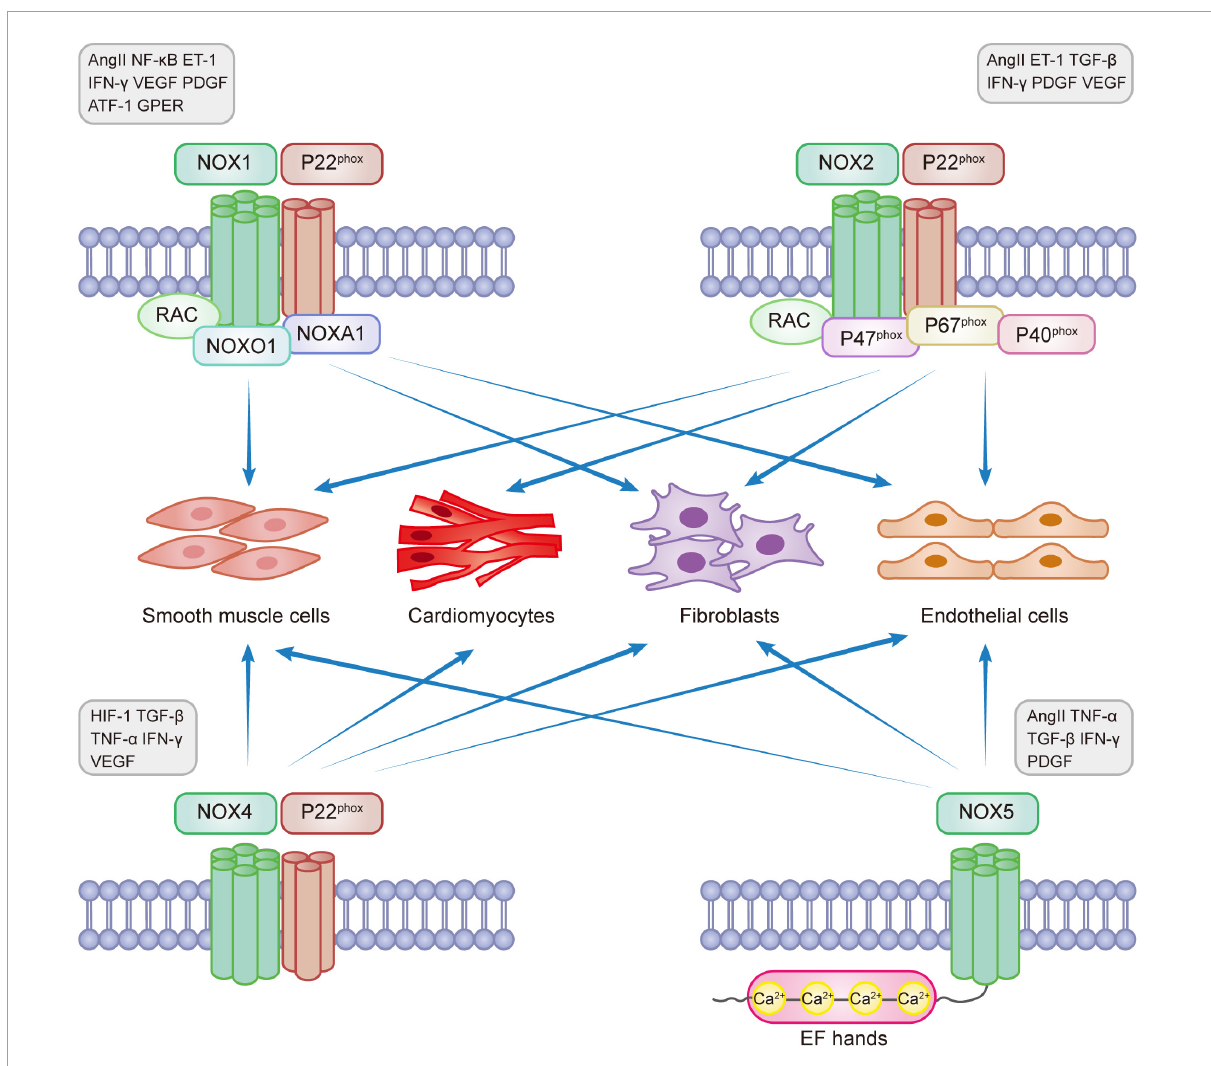
FIGURE1 NADPH oxidase expression in myocardial